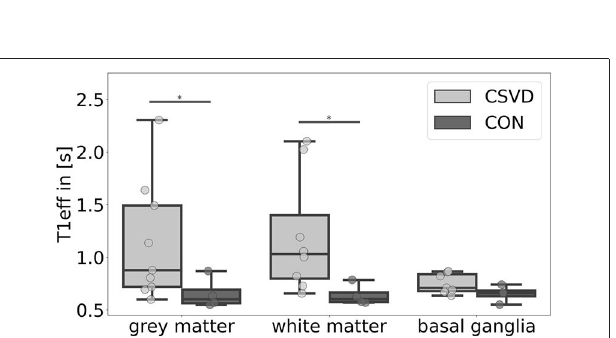
FIGURE 4 | Mean effective T1-relaxation time (T1eff) differences between patients with cerebral small vessel disease (CSVD) and controls (CON) for several regions-of-interest. Significant group differences ( p < 0.05) of mean gray matter and white matter T1eff are marked with